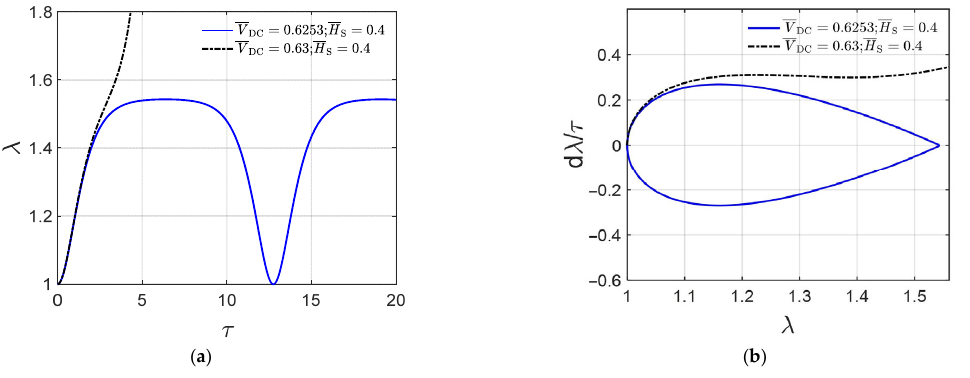
Figure 3. The DC dynamic response of the electro-magneto-active polymer to H = H S = 0.4 and K (cid:3404) 0 . ( a ) Time history and ( b ) phase plane diagram.